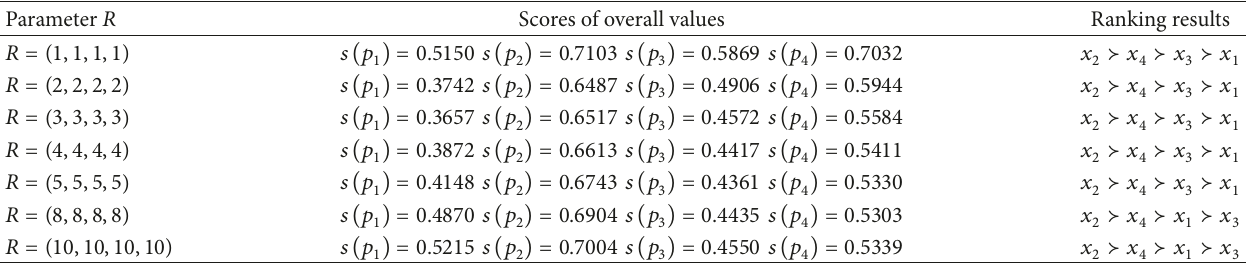
Table 3: Ranking results by assigning different values to parameter vector 𝑅 in the DGPFWBM operator. Parameter 𝑅 Ranking results